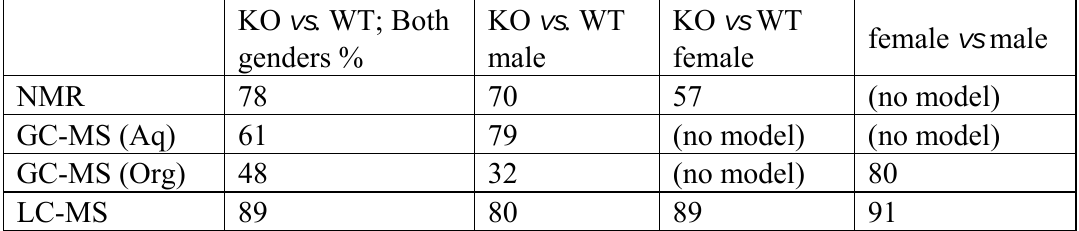
Table 2. Summary of the predictive capability of the models (Q 2 values) for each of the techniques used to measure the metabolome in the heart.